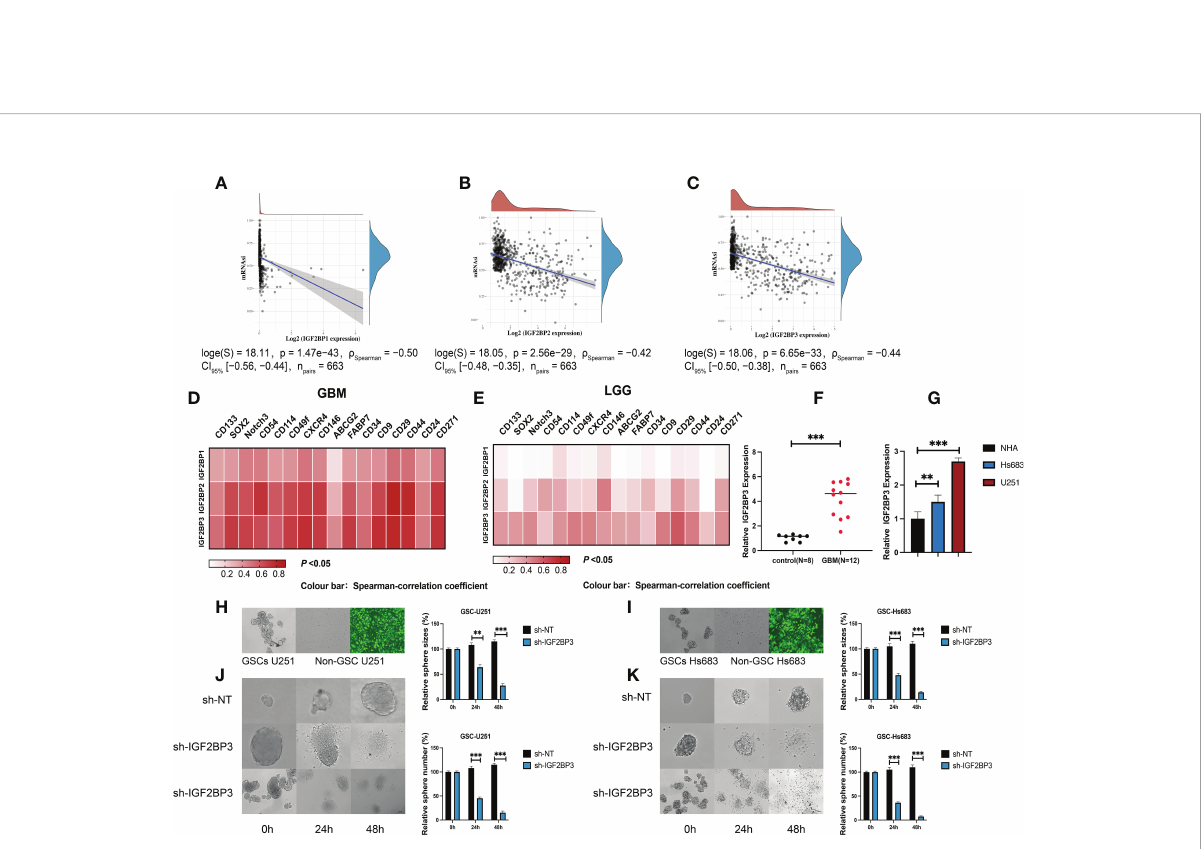
FIGURE 8 IGF2BP3 plays a key role in the maintenance and self-renewal of GSCs. (A – C) The correlation of stemness score and IGF2BPs gene expression. (D, E) GEPIA database showing IGF2BPs expression correlation with stem gene in high-grade glioma tissues compared with that in low-grade glioma tissues. (F) The serum level of IGF2BP3 was signi fi cantly increased in the GBM patients. (G) RT-qPCR analysis of IGF2BP3 expression in glioma cell lines (U251 and Hs 683). (H, I) The representative images of 2 established neutrosphere-cultured GSCs and lentiviral transfection ef fi ciency. (J, K) Sphere formation of U251and HS683 after infection with shRNA-IGF2BP3 and shRNA-NT was evaluated by the sphere formation assay. Bar: 100 m m. **P < 0.01, ***P <